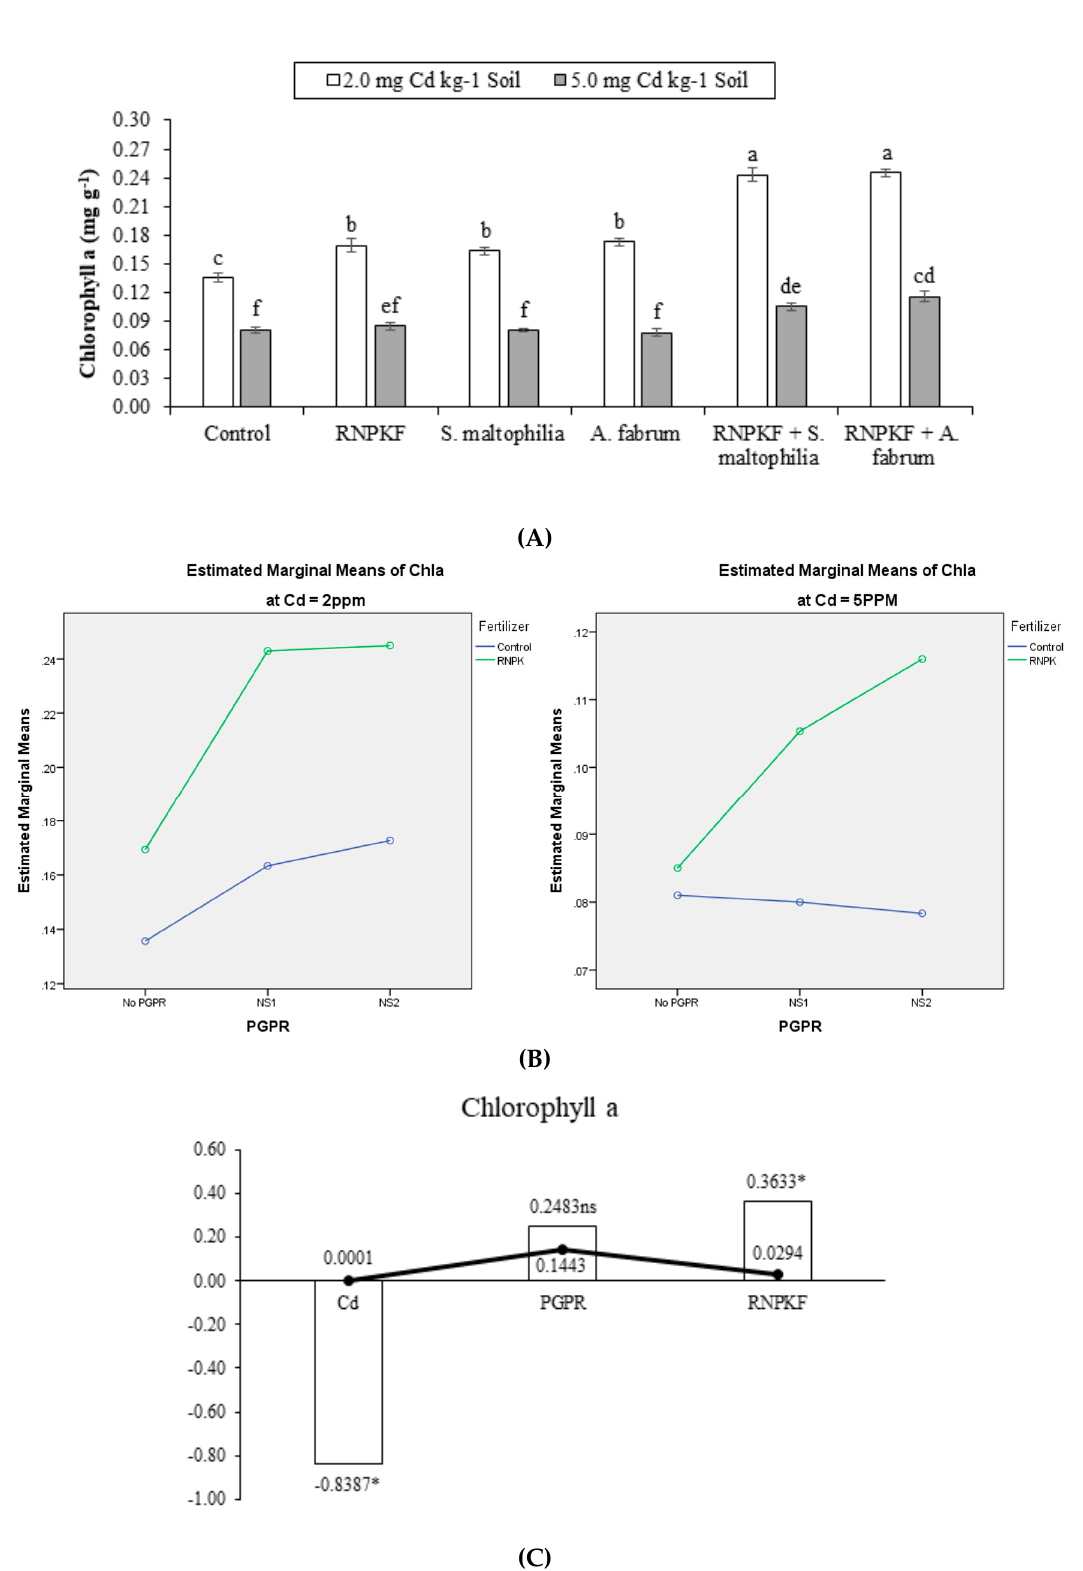
Figure 4. Effect of rhizobacteria with and without recommended NPK fertilizer on chlorophyll a (Chla) of bitter gourd under Cd ( A ). Interaction graph of PGPR (NS1 = S. maltophilia , NS2 = A. fabrum ), RNPKF and Cd levels for Chla (mg g − 1 ) ( B ). Pearson correlation of Chla with different levels of Cd, ACCD PGPR, and recommended NPK fertilizer where the y -axis represents the values of correlation (bars in the graph) and x -axis probability (lines in the graph) ( C ). * = p ≤ 0.05; ns = p > 0.05 non-significant.